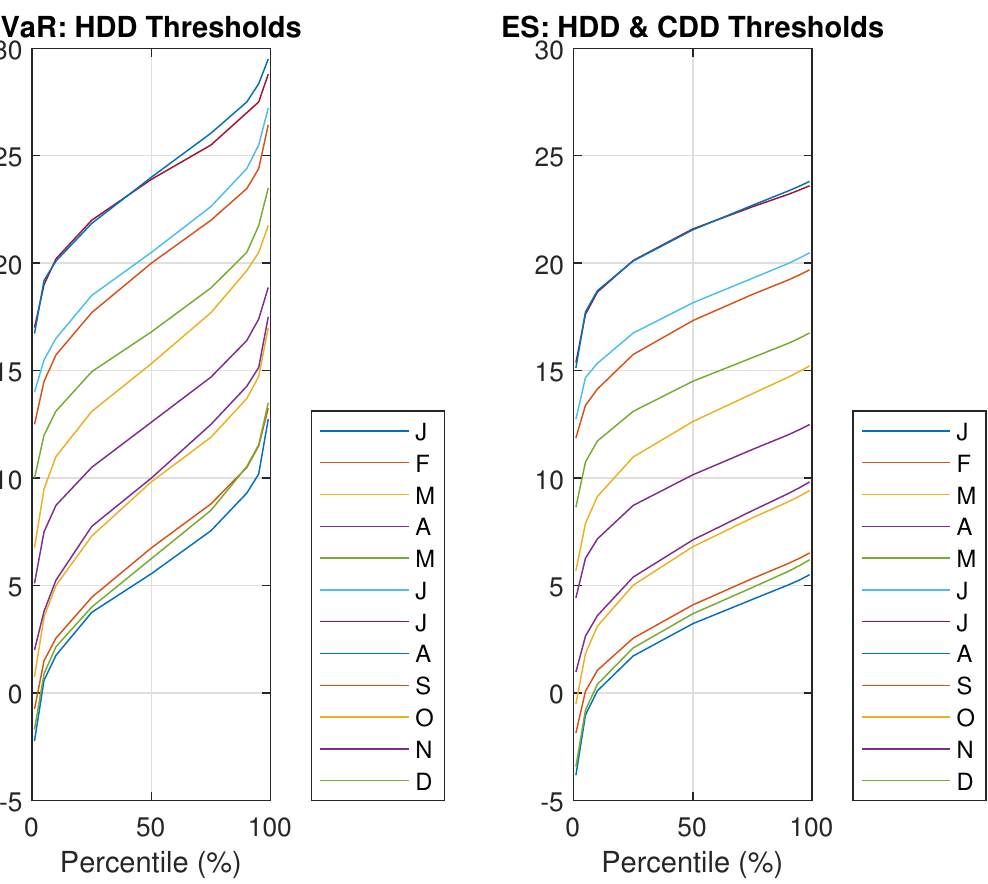
Figure 1. Thresholds K VaR α and K ES α for heating degree days (HDD) and cooling degree days (CDD) for di ff erent confidence levels and in di ff erent months (HDD corresponds to percentiles 0% to 50% while CDD corresponds to percentiles 50% to 100%). Note that the abbreviations J 1 , A 1 , J 2 , J 3 , and A 2 are used to identify the months of January, April, June, July, and August,